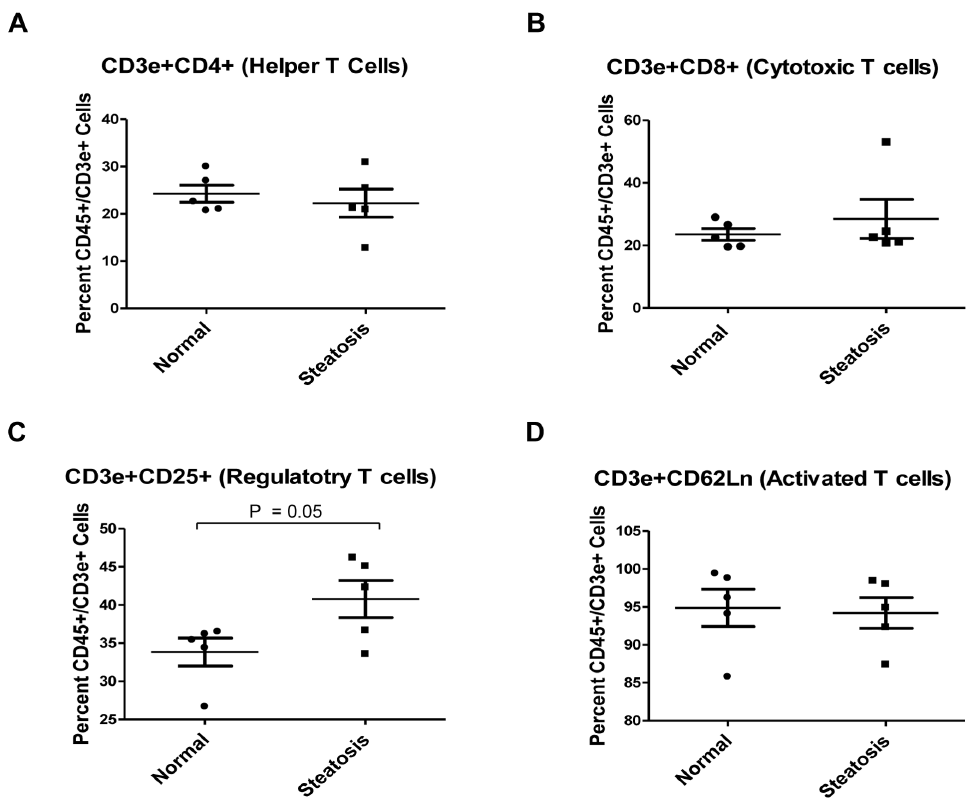
Figure 4. Changes in the lymphoid cell sub-populations in normal vs steatotic murine livers. Isolated CD45 positive cells from normal and steatotic livers were stained for lymphoid markers, subjected to flow cytometry and gated as a fraction of CD3e positive lymphocytic cells. CD3e + cells were analyzed for changes in the total percentage of (A) CD4 positive helper T cells, (B) CD8 positive cytotoxic T cells, (C) CD25 positive regulatory T cells, and (D) CD62L negative activated T cells between normal and steatotic murine livers. Results only showed a significant increase in the overall CD25 + subpopulation of CD3e + cells in the steatotic livers when compared to normal livers.